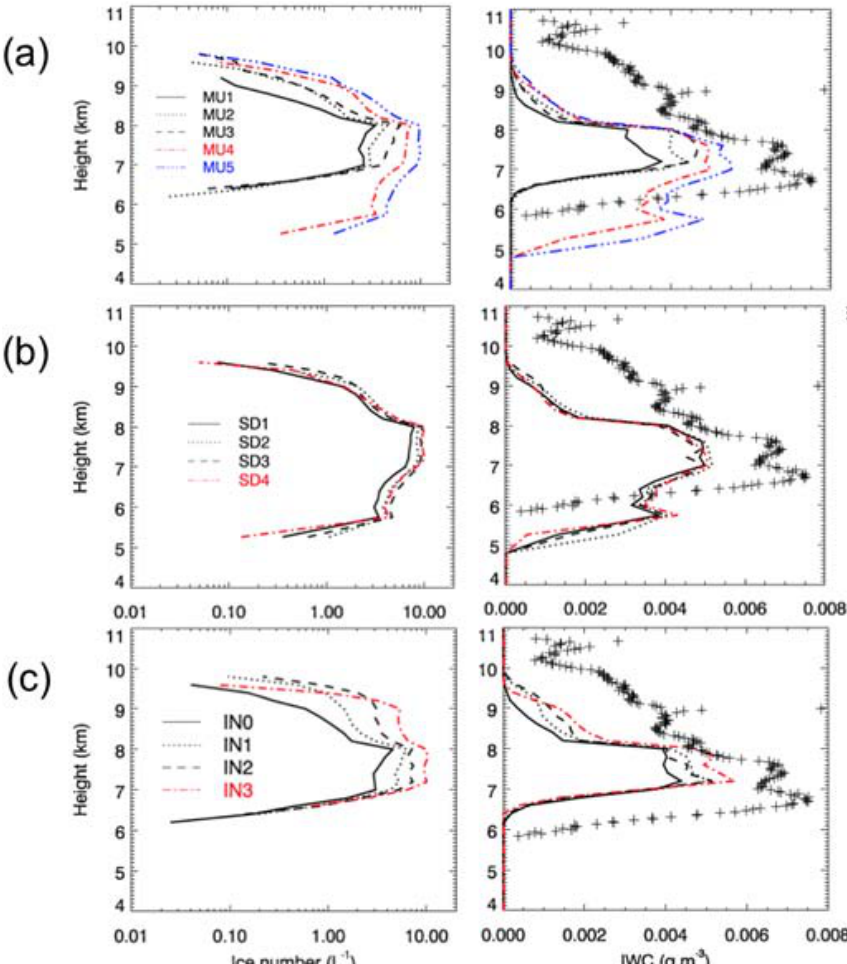
Fig. 9. N i and IWC averaged over the cloudy-points from the sensitivity tests of (a) µ (MU), (b) σ (SD), and (c) N 0 simulated in the CRM. See Table 3 for details. The observed IWC ( + ) was retrieved from the ground-based lidar and radar observations (Comstock et al.,